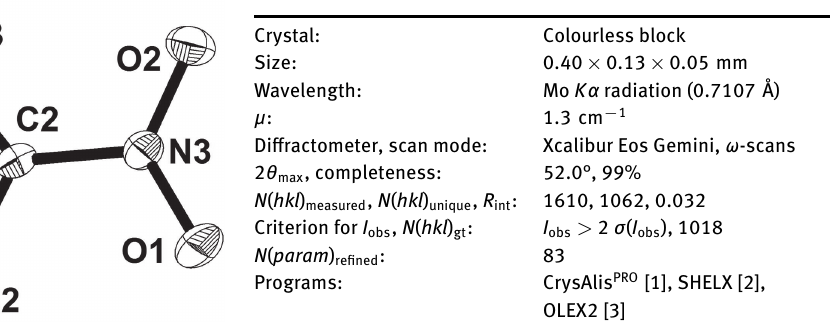
Table 1: Data collection and handling.